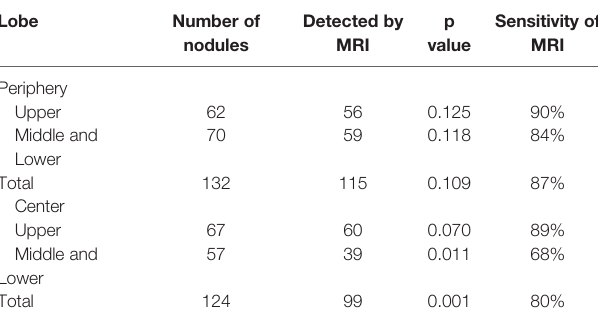
TABLE 3 | No. of Lesions Detected on CT and MRI (Periphery and Center).